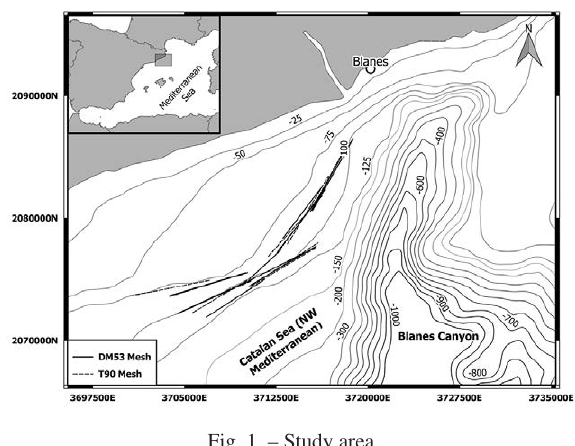
Fig. 1. – Study area.